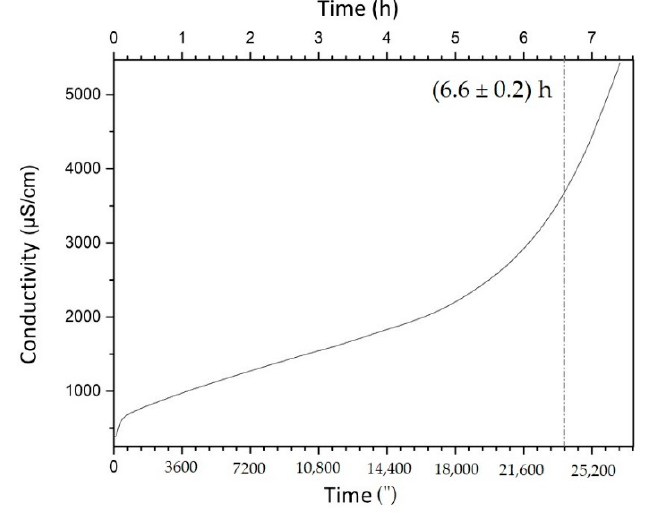
Figure 4. Electric conductivity versus time determined by the Rancimat method for buriti oil.